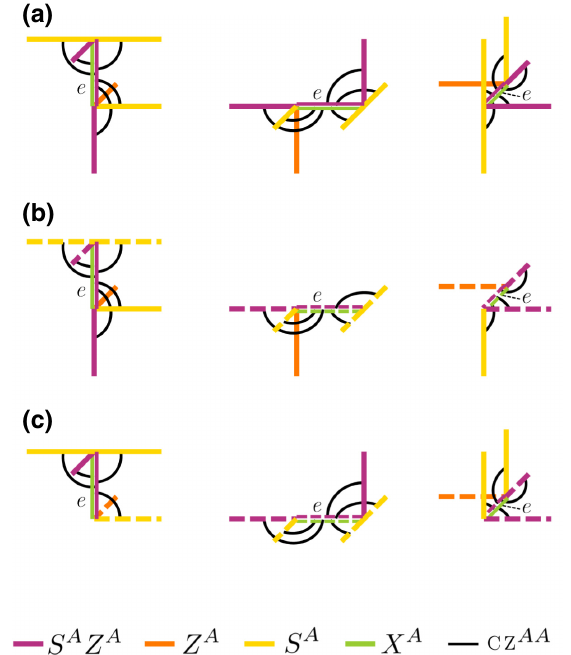
ˆ X e (a) in the bulk, (b) near